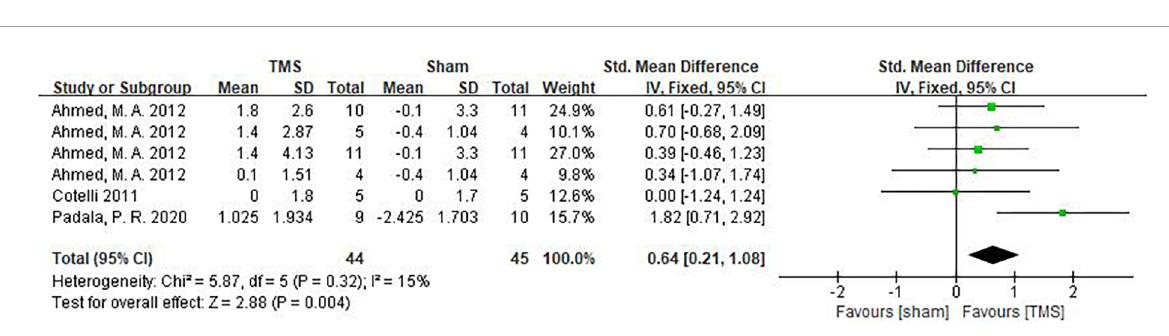
FIGURE9 Forest plot showing the effect of repetitive transcranial magnetic stimulation (rTMS) on IADL of AD patients with 95%